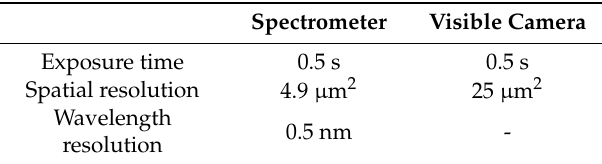
Table 1. Measurement conditions of the emission spectra and photograph.